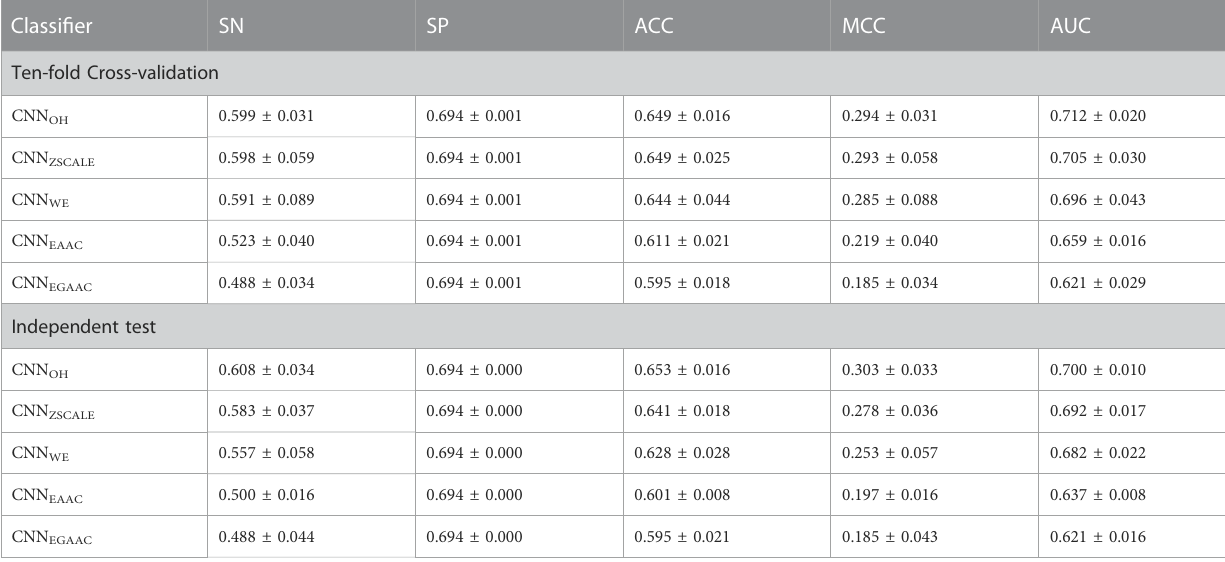
TABLE 1 Prediction performances of CNN-based classi fi ers for the pSADPr-SADPr dataset a .